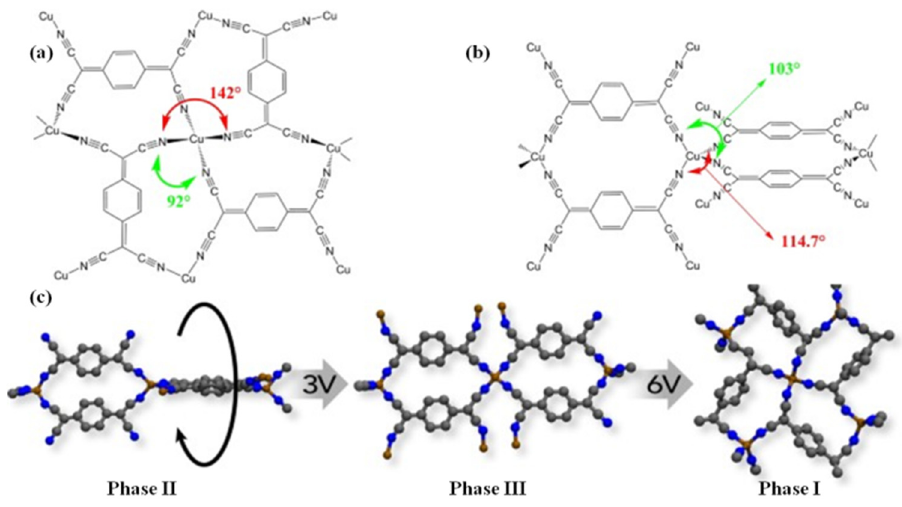
Figure 5. Chemical structure of Cu(TCNQ) in phase I ( a ) and phase II ( b ). ( c ) Single crystal structure transition of Cu(TCNQ) from high resistance state (phase II) to proposed new state at 3 V (phase III) followed by transition to conductive state (phase I) at 6 V. Reprinted with permission from Ref. [52]. Copyright 2014, Nature Publishing Group.